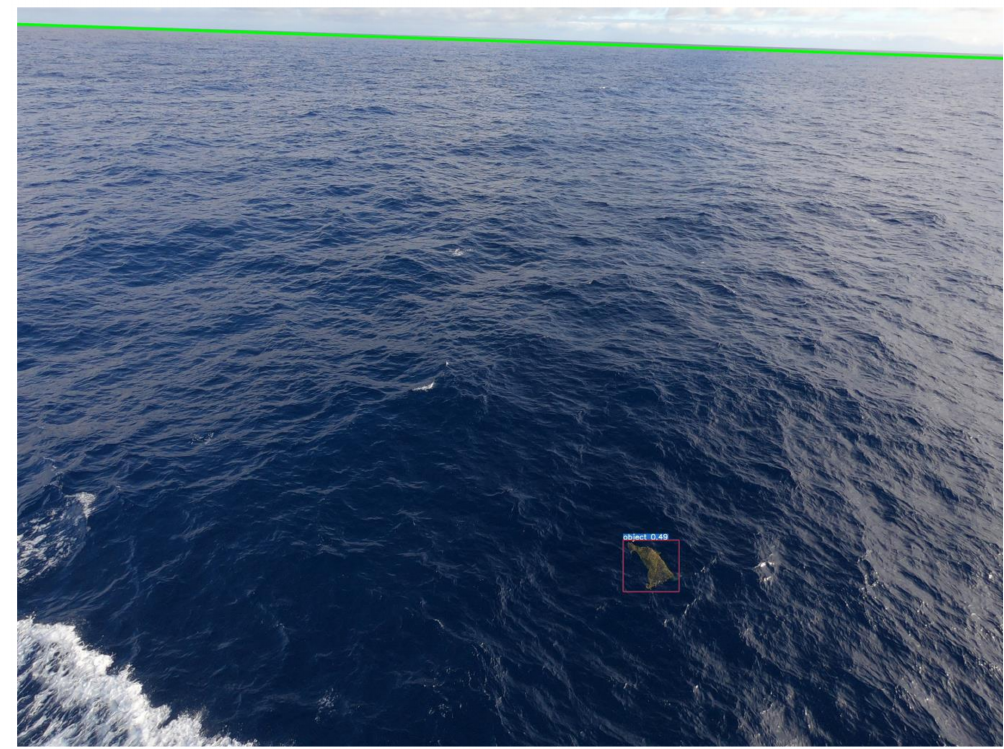
Figure 6. Example image extracted from an intermediate processing stage in the algorithm. The green line denotes the detected horizon. A bounding box indicates a large detected object in the lower right quadrant of the image. Relative to the full image size, this large object is still small.